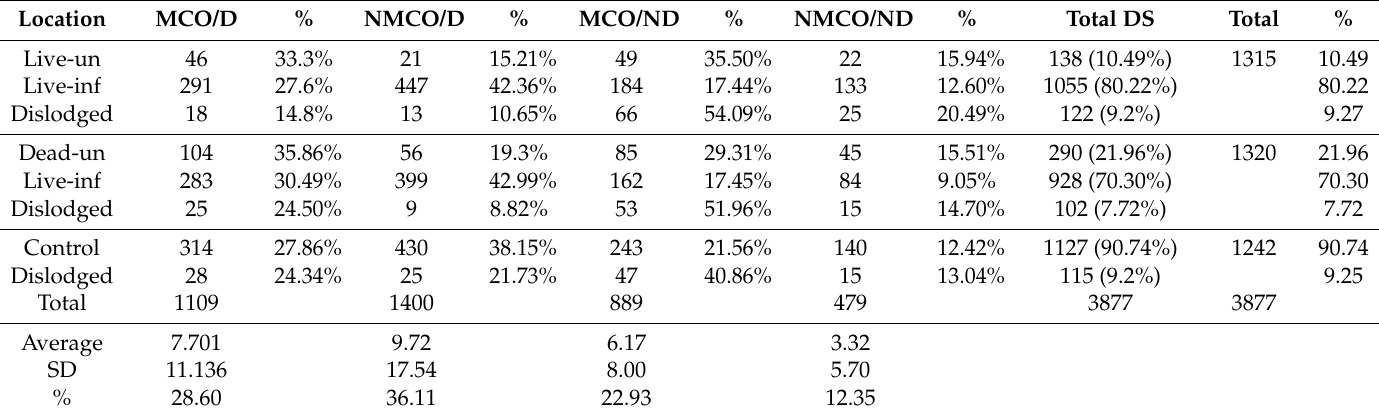
Table 3. Three hours cohabitation experiment on parasite transmission showing the developmental status of gyrodactylids using combinations of fish (Experiment 3) ( n =